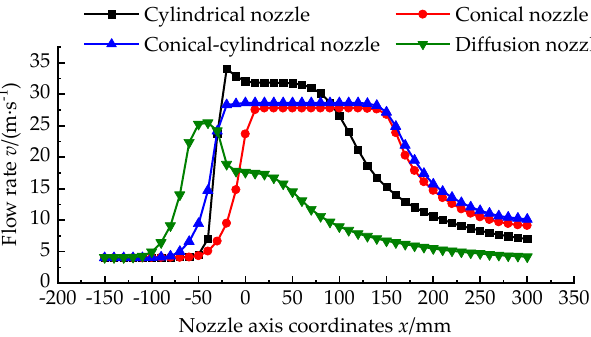
Figure 7. Nozzle centre axis fluid velocity diagram.